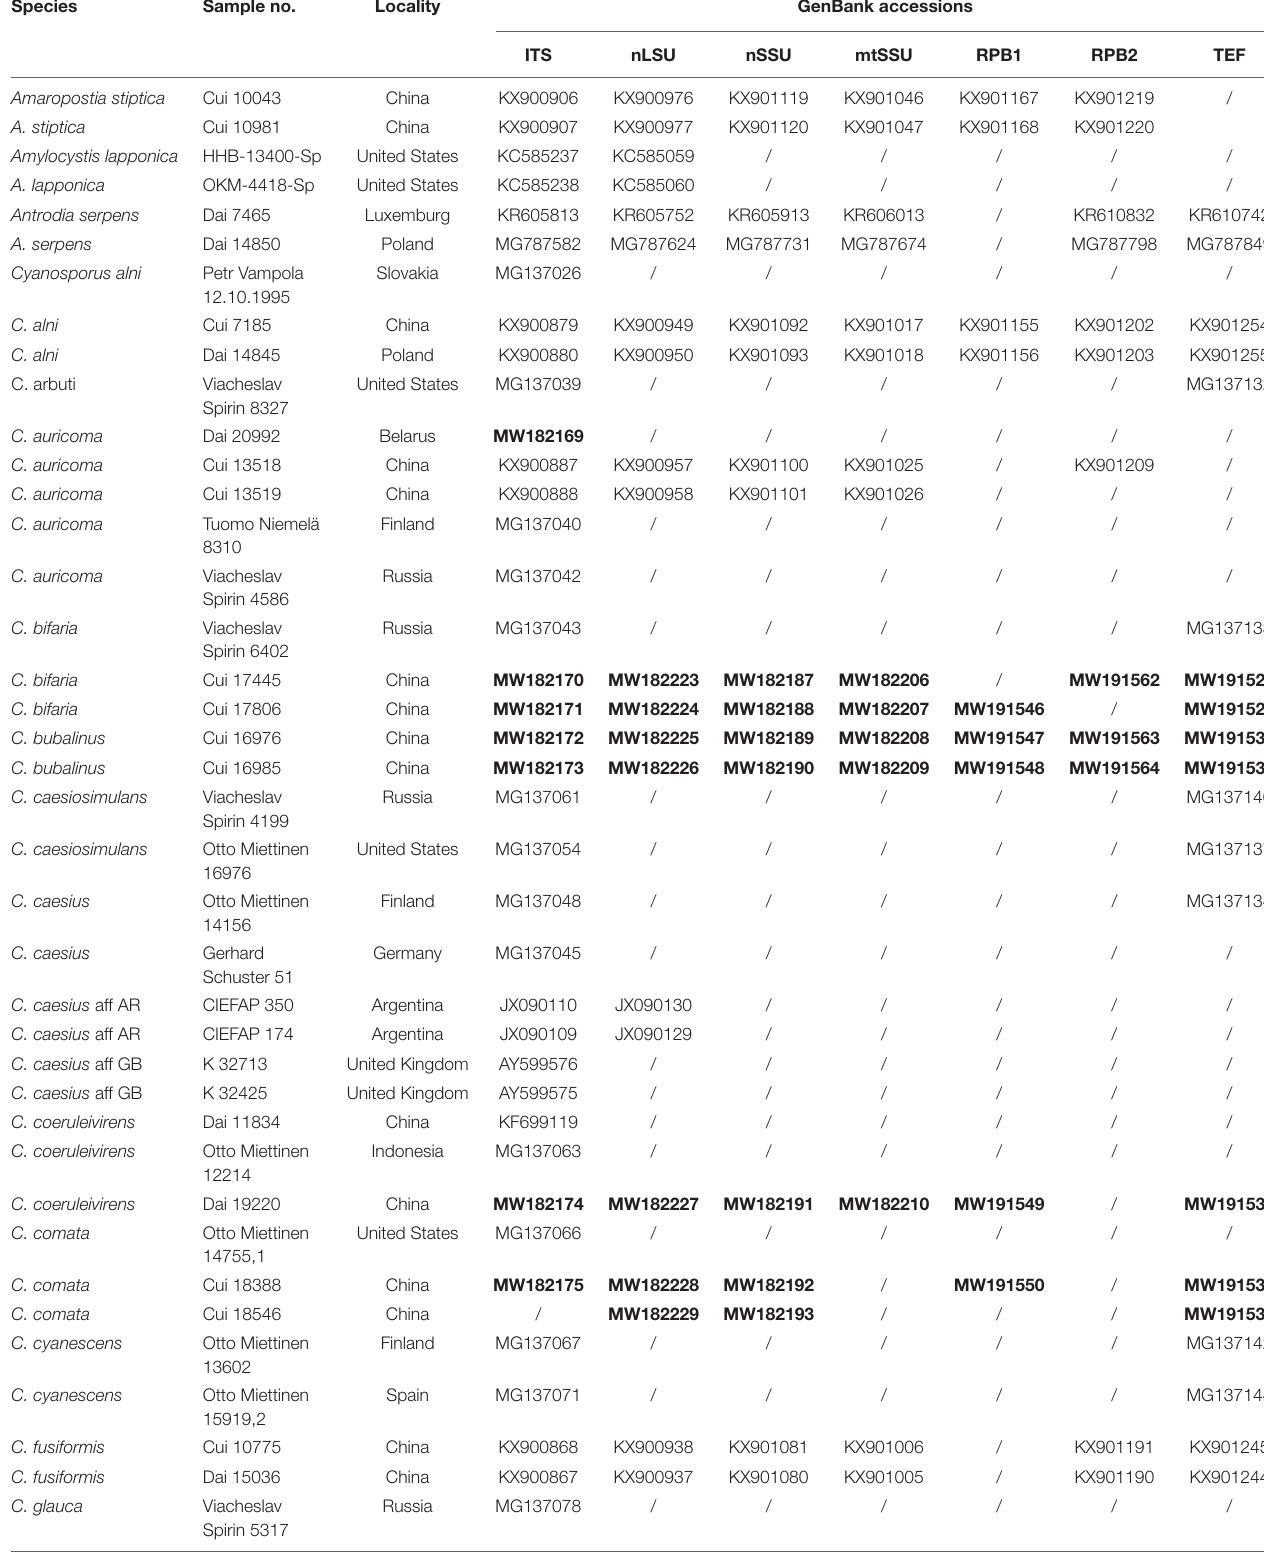
TABLE 1 | A list of species, specimens, and GenBank accession number of sequences used for phylogenetic analyses in this study. Species Sample